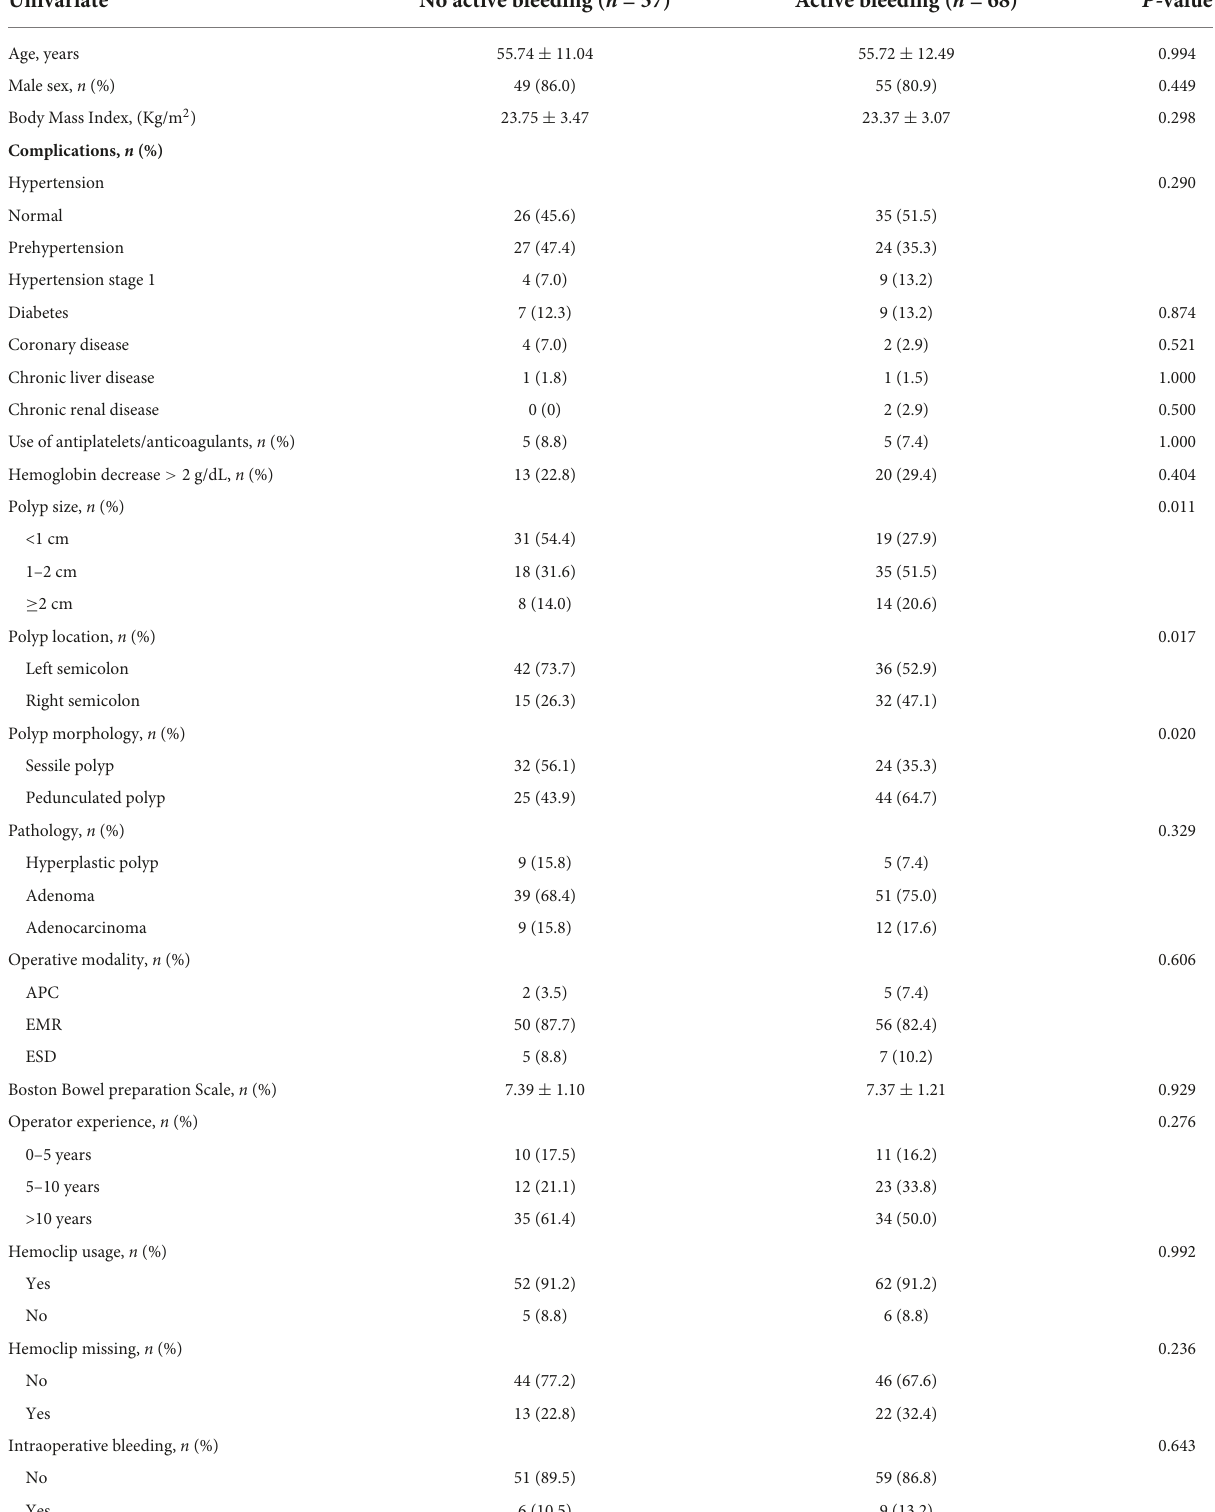
TABLE 6 Univariable analysis and multivariable logistic analysis of factors associated with active bleeding during the second colonoscopy. Univariate No active bleeding ( n =